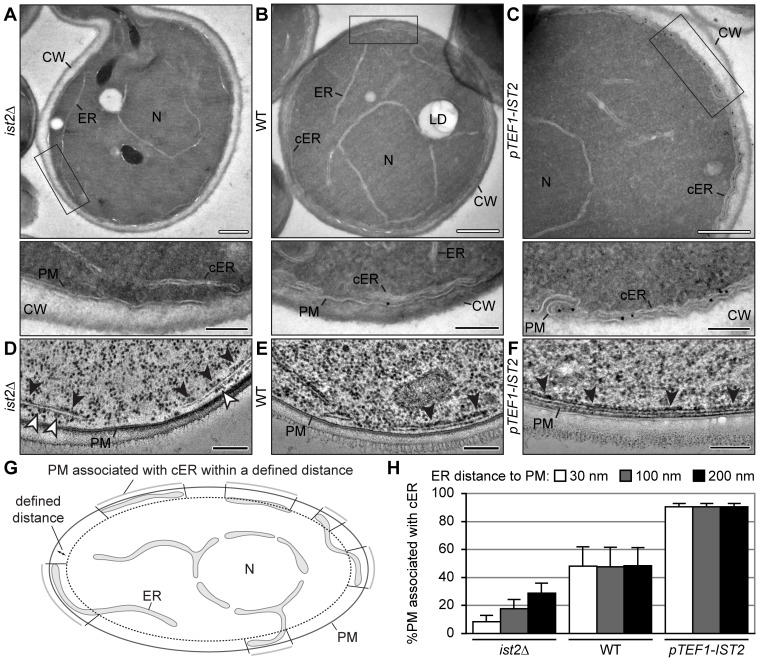
Ist2 recruits yeast ER to the PM.(A–F) Yeast cells expressing different amounts of Ist2 (ist2Δ in A and D, WT in B and E, and pTEF1-IST2 in C and F) were grown to log phase in YPD medium. (A–C) Cells were chemically fixed and ultrathin cryo-sections of gelatine-embedded cells were subjected to immuno-gold labelling using anti-Ist2 antibodies and protein A-10 nm gold. Lower panels show higher magnification of the indicated areas. Please note that cross sections in A–C are shown at different magnification. The average size of ist2Δ, WT and pTEF1-IST2 cells is similar, as revealed by light microscopy (data not shown). (D–F) Cells were high pressure frozen, freeze substituted and Epon embedded. Ribosome-studded ER is indicated by black arrowheads. (D) Ribosomes on the PM face of the cortical ER in ist2Δ are indicated by white arrowheads. Organelles and membranes are labelled (PM, plasma membrane; CW, cell wall; ER, endoplasmic reticulum; cER, cortical ER; N, nucleus; LD, lipid droplet). White bars correspond to 500 nm and black bars to 200 nm. (G) Cartoon illustrating the morphology of ER. For quantification PM and ER were traced in electron micrographs of representative cells after chemical fixation. The relative amount of PM associated with cortical ER within a defined distance (dotted line) was analyzed. (H) Quantification of PM fraction associated with cortical ER within a distance of 30 nm (white), 100 nm (grey), and 200 nm (black) in the indicated strains. Values represent the mean of independent images (ist2Δ: n = 12; WT: n = 10; pTEF1-IST2: n = 9). Error bars indicate the s.d.